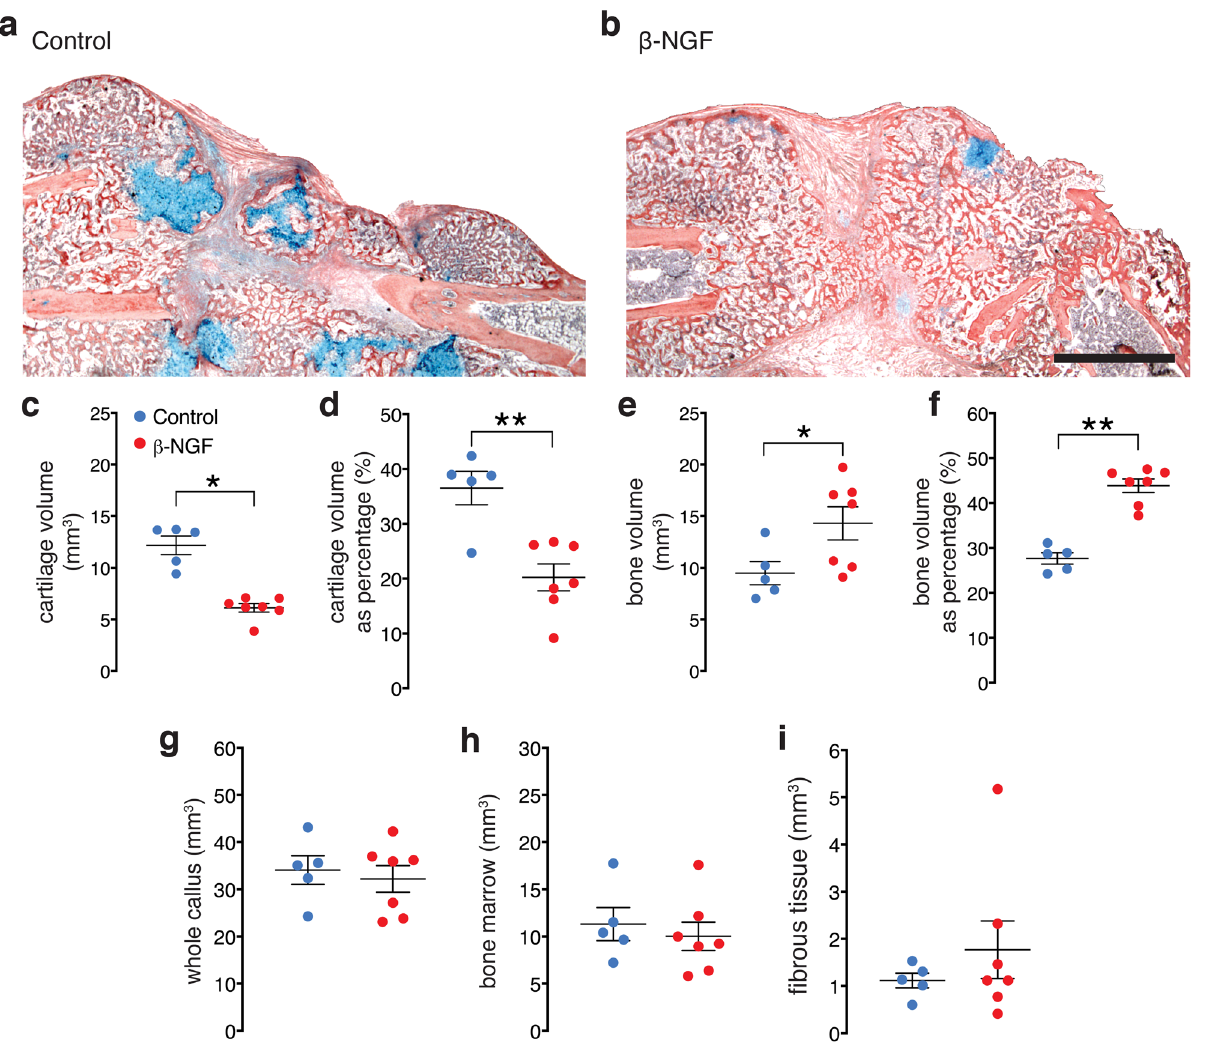
Figure 5. Local injections of β-NGF results in less cartilage and more bone. Representative images of HBQ stained section of fracture callus from ( a ) control group and ( b ) β-NGF group, 14 days post fracture. Scale bar: 500 μm. Quantification of cartilage volume in both treatment groups, shown as ( c ) absolute volume and as ( d ) percent composition of the total callus volume. Quantification of bone volume in both treatment groups shown as ( e ) absolute volume and ( f ) percent composition. Quantification of ( g ) whole-callus volume ( h ) bone marrow and ( i ) fibrous tissue. All measured by stereology. Error bars represent SEM. *p < 0.05; **p < 0.01 determined by 2-tailed t